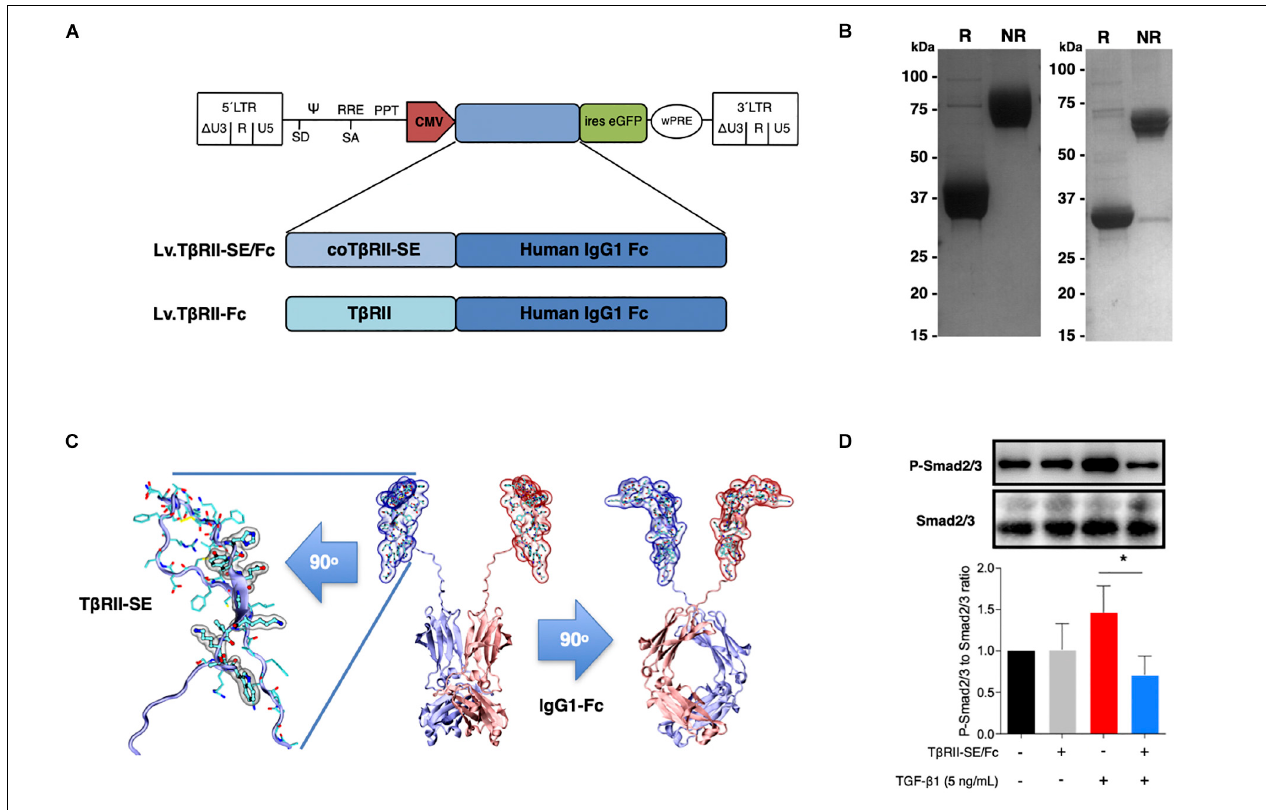
FIGURE 3 | T β RII-SE/Fc overexpressed in human cells is secreted to the extracellular milieu as a disulfide-linked homodimer and inhibits Smad2/3 activation. (A) Either coT β RII-SE/Fc or T β RII-EC was ligated to the human IgG1 Fc coding sequence and cloned into a self-inactivating (SIN) bicistronic lentiviral vectors making Lv.T β RII-SE/Fc and Lv.T β RII-Fc, respectively. The proviral lentiviral vectors contain long terminal repeat sequences (LTRs) on both ends, devoid of LTR promoter/enhancer sequences ( (cid:49) U3) after reverse transcription. The cytomegalovirus (CMV) promoter was used as internal promoter to drive the expression of either T β RII-SE/Fc or T β RII-Fc. Furthermore, the vectors include the safety-improved woodchuck hepatitis virus post-transcriptional regulatory element (wPRE), a splice donor (SD), a splice acceptor (SA) and the packaging signal ( (cid:57) ), together with the Rev responsive element (RRE), and the central polypurine tract (PPT). (B) SDS-PAGE and Coomassie blue staining of Protein A/G purified supernatants of T β RII-SE/Fc-overexpressing 293T cells under reducing (R) and non-reducing (NR) conditions. (C) Dimeric 3D model of T β RII-SE/Fc using the structures 2PJY (T β RII) and 1L6X (Fc), as templates (middle panel). T β RII-SE is shown magnified and rotated 90 ◦ (left panel) with atomic representation wrapped in its solvent-accessible surface area. Amino acids with solvent-accessible surface (highlighted in gray) are part of the protein-to-protein interface. Also, T β RII-SE/Fc 3D model is shown rotated 90 ◦ (right panel). (D) Representative immunoblotting (top panel) and semi-quantitative densitometry of three independent experiments (bottom panel) of P-Smad2/3 and total Smad2/3 in HCT116 cells overexpressing T β RII-SE/Fc (+) and control (–), in the presence (+) and absence (–) of TGF- β 1 stimulation. * p <